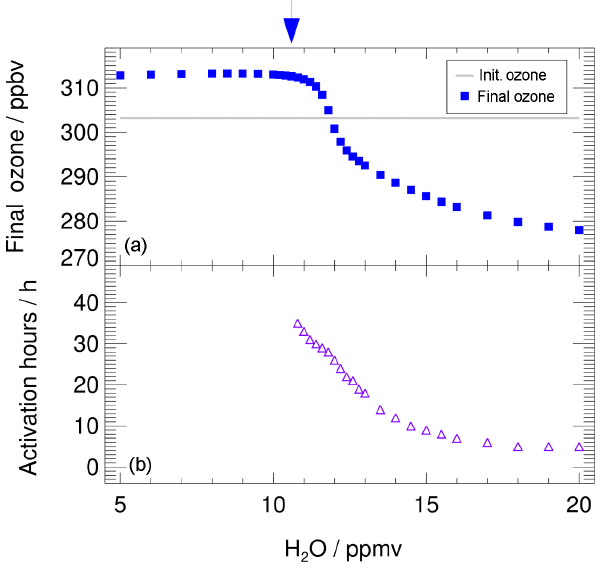
Figure 3. Impact of the water vapour content on the ozone mixing ratio (final ozone, a ) reached at the end of the 7d simulation along the standard trajectory and assuming standard conditions. The ini- tial ozone amount is marked by the grey line. The arrow marks the water vapour threshold, which has to be exceeded for chlorine acti- vation at standard conditions to occur. In (b) , violet triangles show the time until chlorine activation occurs. For low water vapour mix- ing ratios no chlorine activation